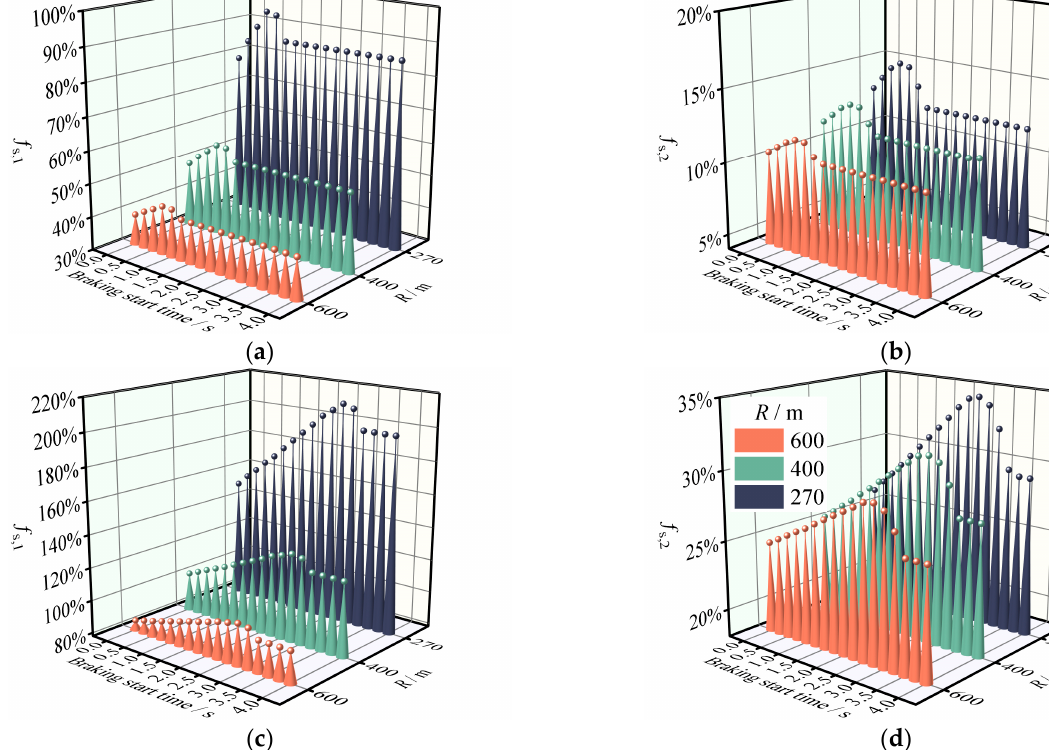
Figure 10. The SUV’s safety margin reduction rate on horizontal curves and grade combinations when braking and lane changing are combined (LCD = 4 s). ( a ) Sideslip margin reduction rate for LC_A with braking maneuver. ( b ) Rollover margin reduction rate for LC_A with braking maneuver. ( c ) Sideslip margin reduction rate for LC_B with braking maneuver. ( d ) Rollover margin reduction rate for LC_B with braking maneuver.